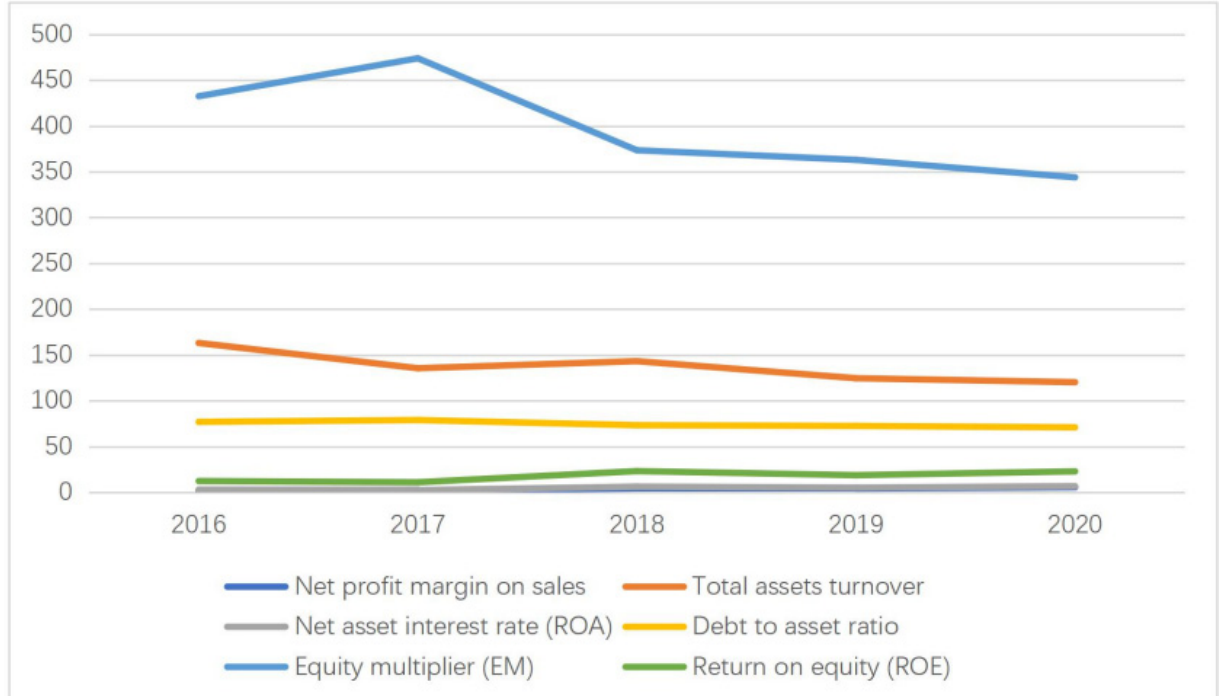
Figure 4. Amazon’s indicator line chart.